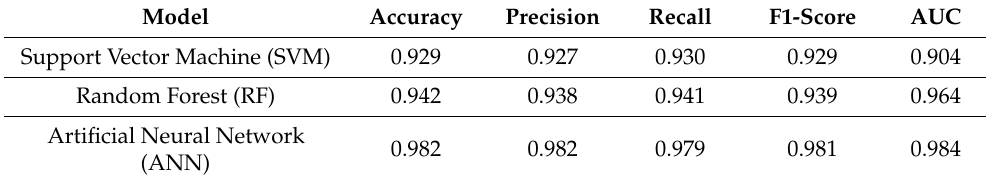
Table 2. Evaluation metrics of the average values of five species for each machine learning model.